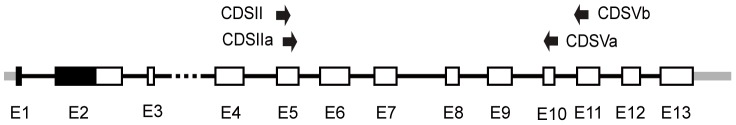
Structure of the CDS gene of Chrysanthemum lavandulifolium and the placement of primers.Gray, black, and white boxes represent 5′ and 3′ UTR, the encoding region of the predicted plastid targeting peptide and exons, respectively. Lines represent introns, and dots indicate the long intron. Arrows indicate the locations of the primers.